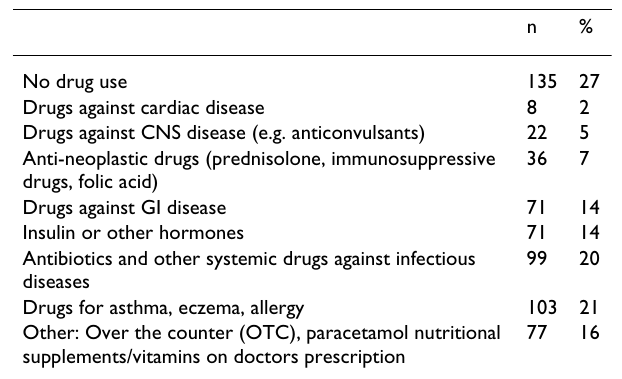
Table 3: Use of prescription drugs in the past month. *Based on table by Madsen et al .[14] [N = 493]